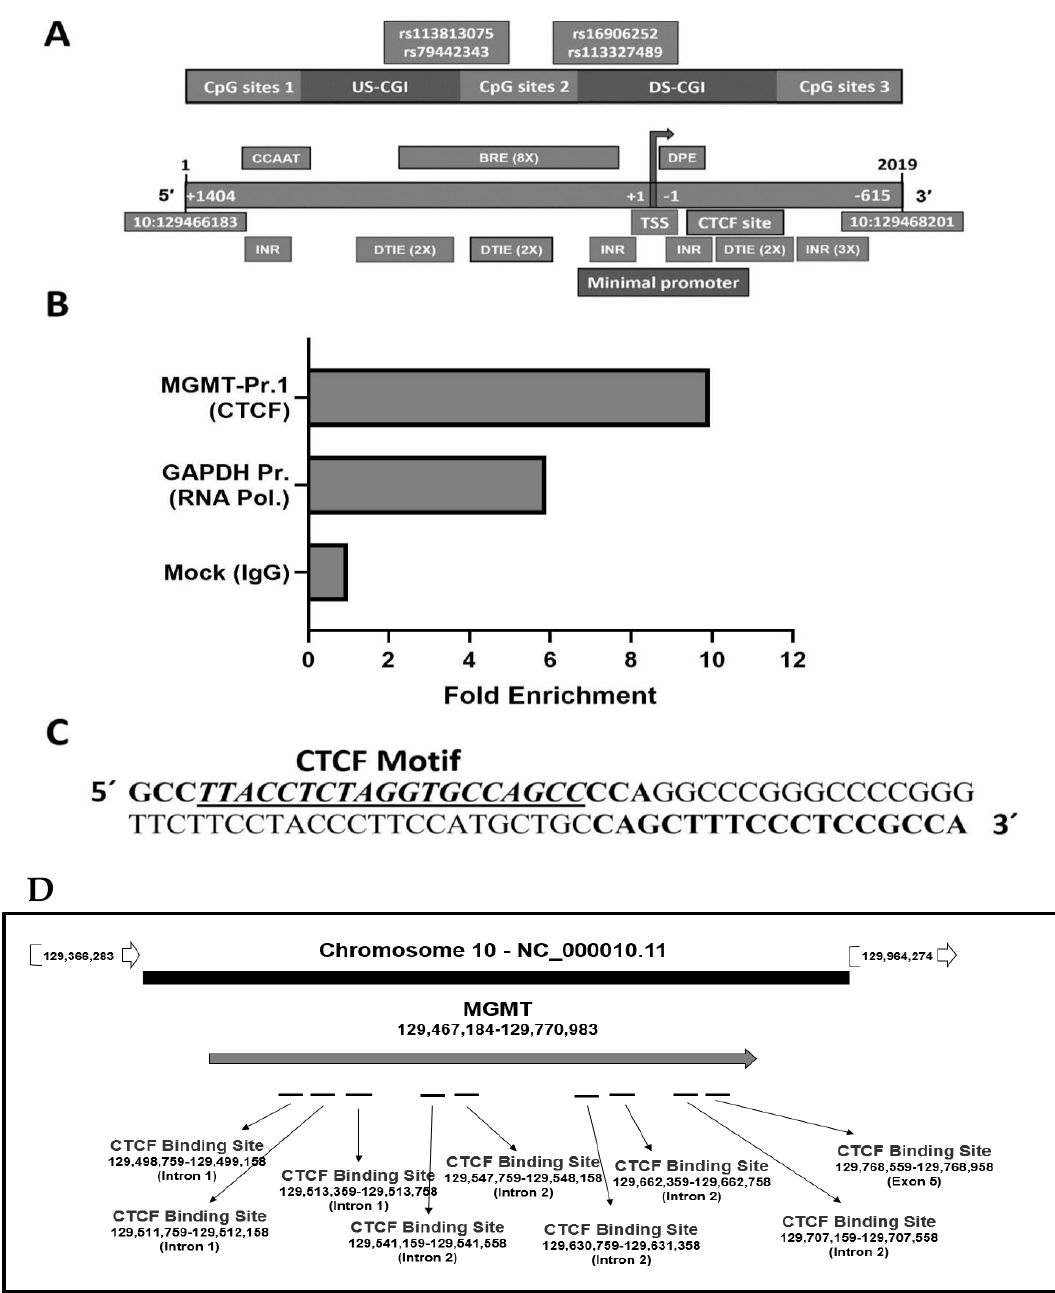
Figure 5. Identification of CTCF binding motifs in MGMT promoter, the body of the gene, and validation of its presence by Chip assay in the human MGMT revised exon-1 promoter. ( A )—Mapping of the two CGIs (upstream and downstream of TSS) and in-silico identification of binding sites for CTCF and other transcription factors associated with initiation therein. INR—Initiator element which facilitates binding of transcription factor II D; DTIE and BRE recruit the TFIID and TFIIB respectively. DPE-Downstream Promoter Element. ( B )—Identification of the CTCF binding sequence in the promoter by ChIP assay. CTCF and RNA Polymerase- bound genomic DNA fragments were isolated from the SF-188 glioblastoma cells using the respective antibodies. CTCF-bound DNA was amplified for the MGMT Promoter-1 and RNA-pol DNA for the GAPDH promoter (used as a positive control). Normal IgG alone served as a negative control. The PCR fragments were electrophoresed, photographed, and quantitated by densitometry. ( C )—The sequence of 19 nucleotide CTCF binding site present in the MGMT promoter is shown. ( D )—The distribution of nine CTCF binding sites present in MGMT genomic space as revealed by the Ensembl database